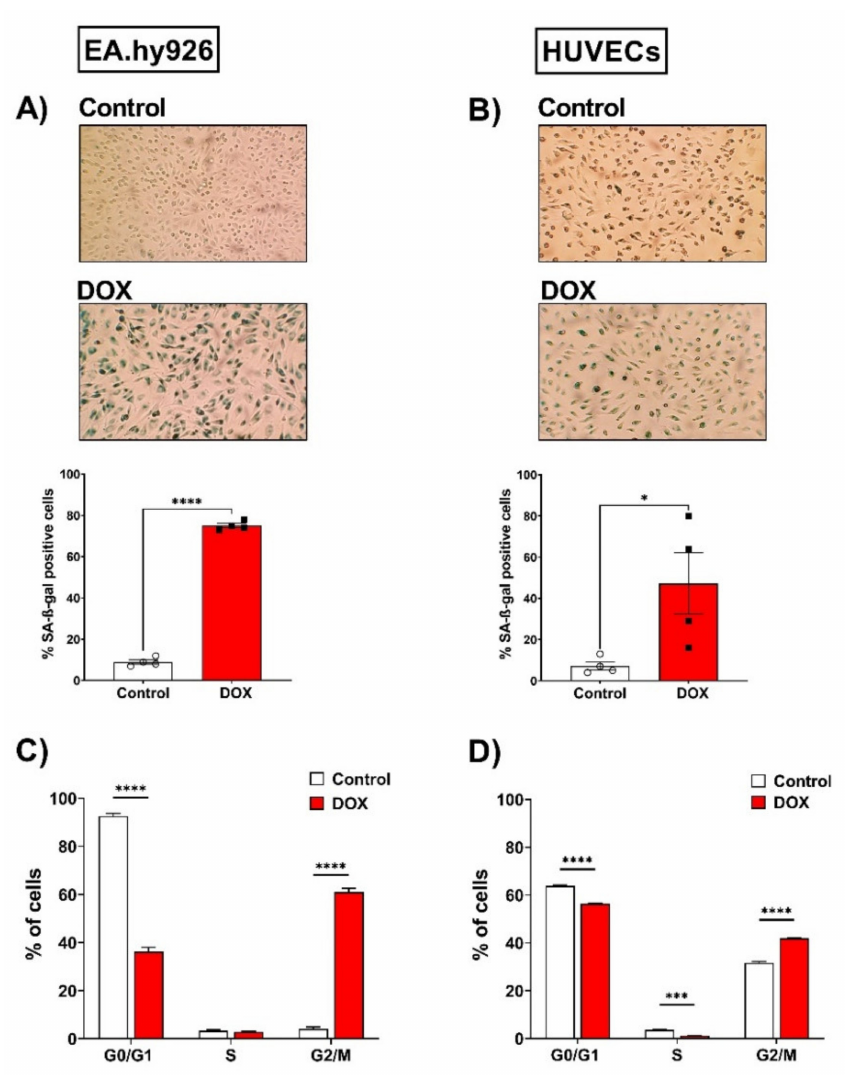
Figure 2. Doxorubicin triggers senescence in EA.hy926 cells and HUVECs, as demonstrated by the increased SA- β -gal activity and cell cycle arrest. EA.hy926 human-endothelial-derived cells and HUVECs were treated with DOX (0.5 µ M) for 24 h. Thereafter, DOX was removed and cells were incubated with DOX-free media for 120 h then stained for SA- β -gal. Images of SA- β -gal staining of EA.hy926 cells ( A ) and HUVECs ( B ) are shown. The percentage of SA- β -gal positive cells were calculated. Data were analyzed via unpaired two-tailed t-test. In another set of experiments, cells were incubated with DOX-free media for 72 h and the cell cycle was analyzed by measuring the DNA content using the FACSCanto system. Percentages of each cell cycle phase in control and DOX-treated cells ( n = 5–6) are shown for EA.hy926 ( C ) and HUVECs ( D ). Data are presented as means ± SEM. Data were analyzed via two-way ANOVA followed by Sidak’s post hoc test. Note: * p < 0.05, *** p < 0.001, **** p <